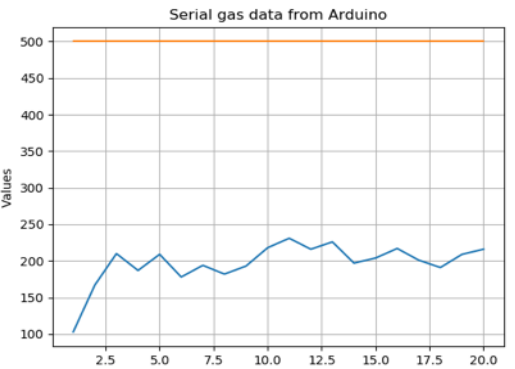
Figure 8. The gas levels in clean air, with 500 ppm threshold (Ox = seconds, Oy = ppm value).